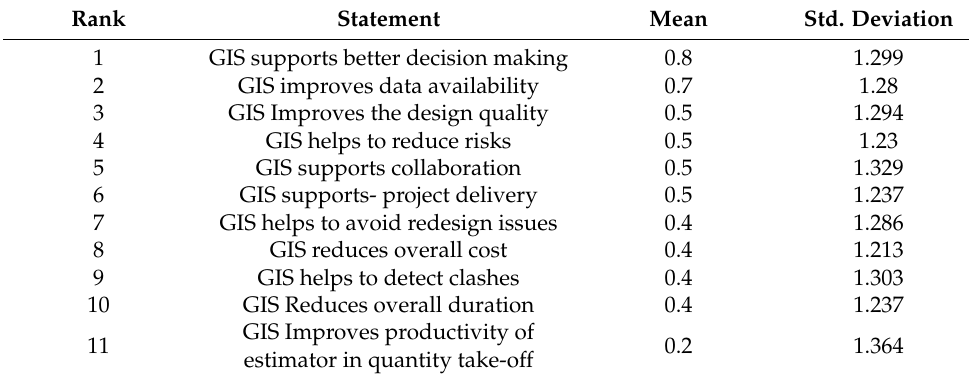
Table 2. Benefits of